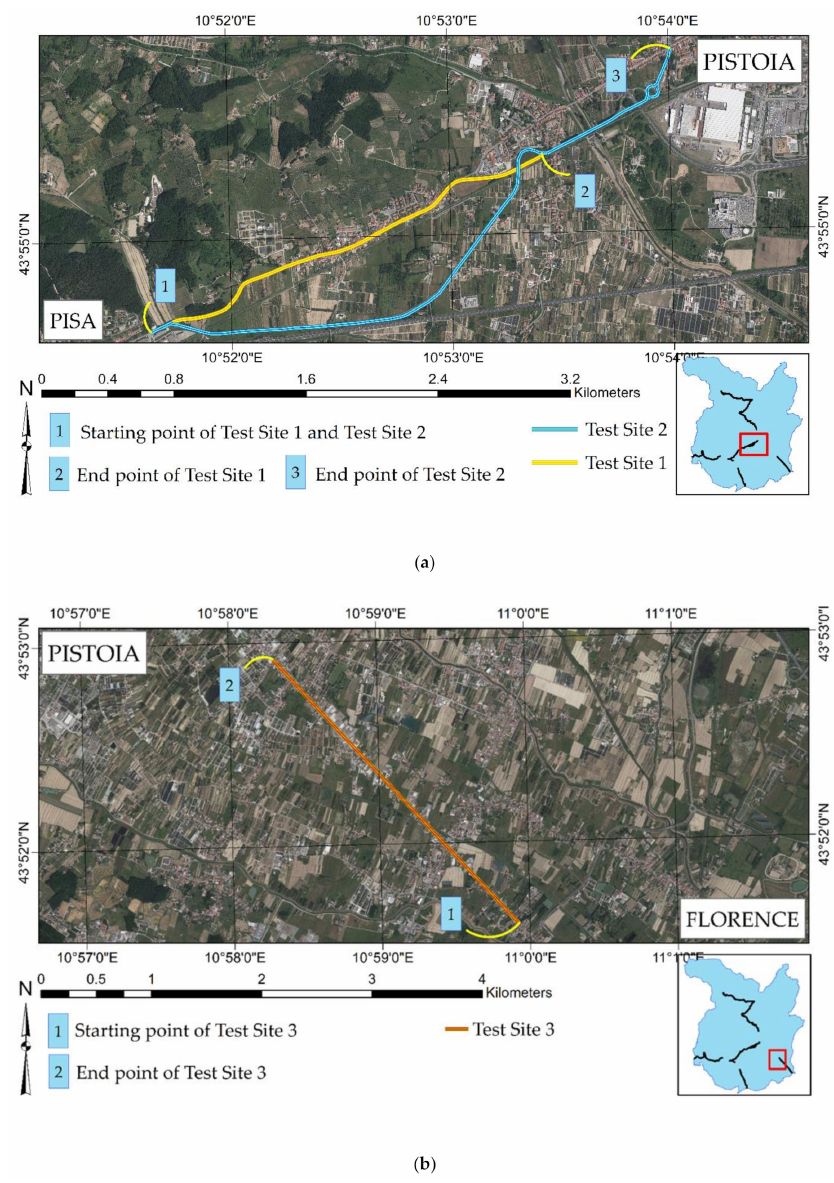
Figure 3. Test sites: ( a ) test site 1 and test site 2. ( b ) Test site